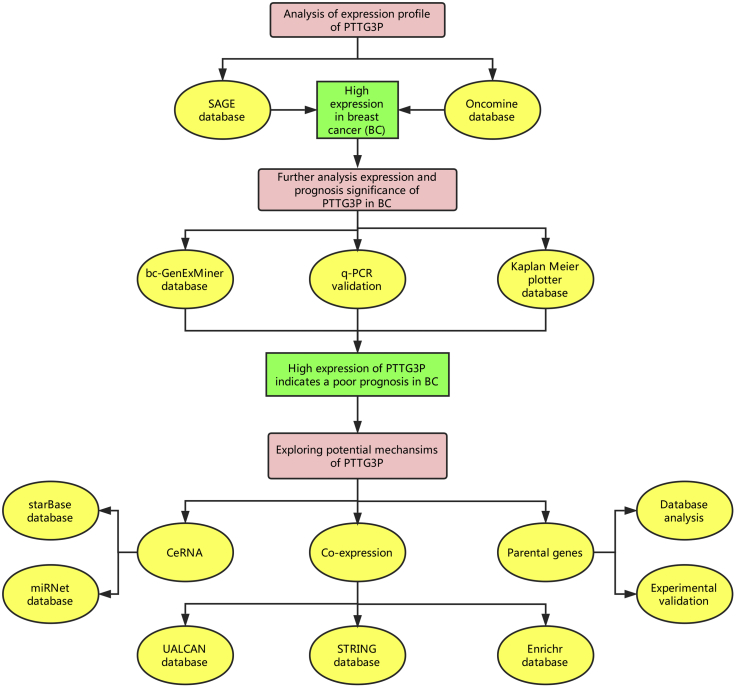
The Visual Flow-Process Diagram of This Study